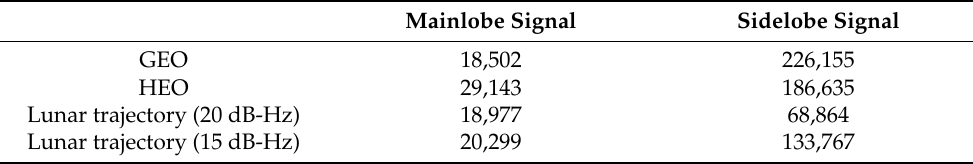
Figure 7. C / N 0 of mainlobe and sidelobe signals for three types of spacecraft: ( a ) GEO; ( b ) HEO; ( c ) Lunar trajectory (20 dH-Hz); ( d ) Lunar trajectory (15 dH-Hz). Table 7. Number of observations from mainlobe and sidelobe